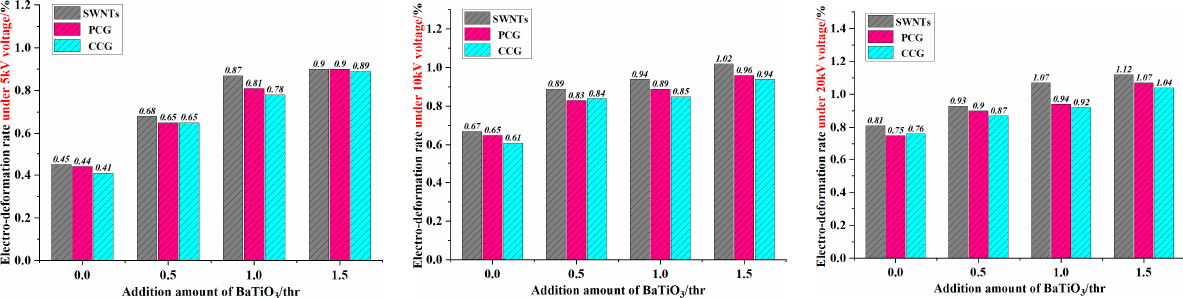
Figure 6. Diagram for electro deformability of actuating unit encapsulated with different electrodes.